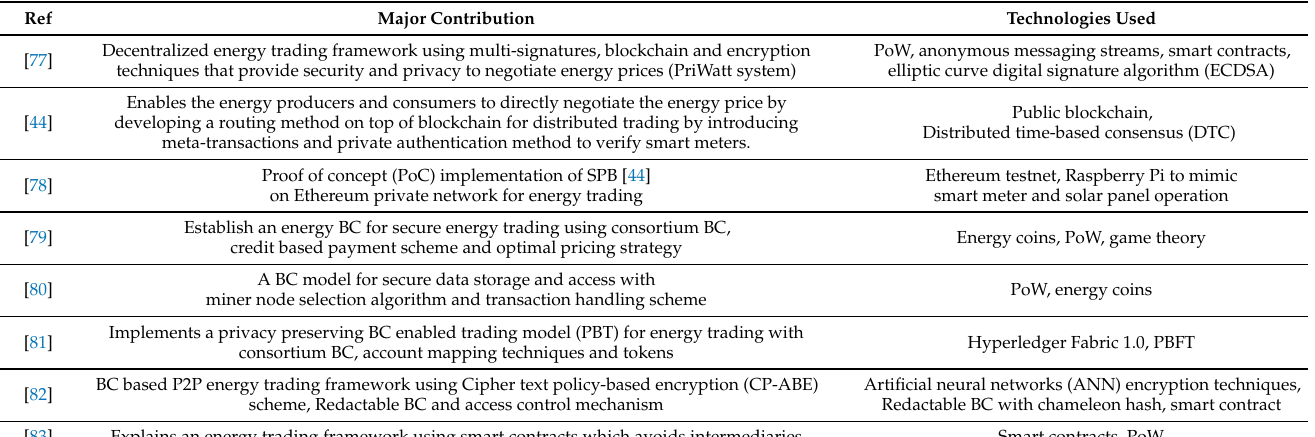
Table 5. Summary of existing works related to energy trading using blockchain.